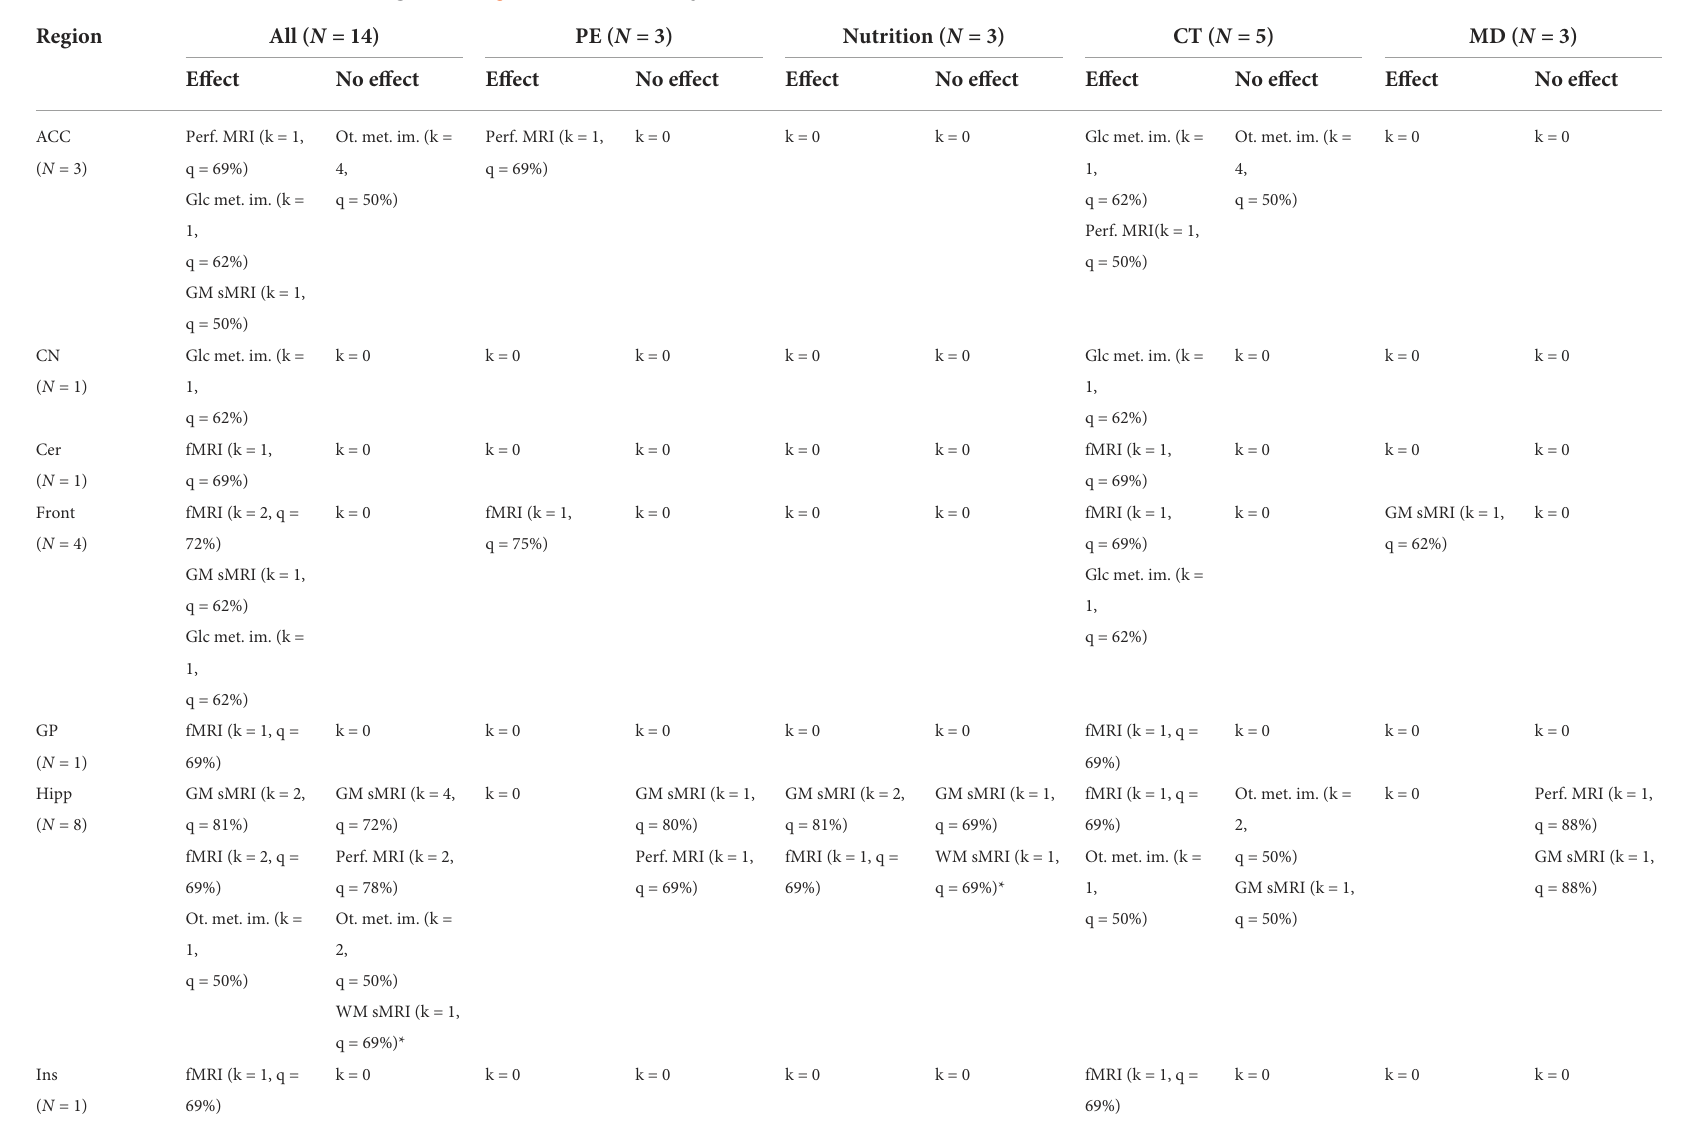
TABLE 9 Effects of interventions on brain regions (see Figure 3) for each